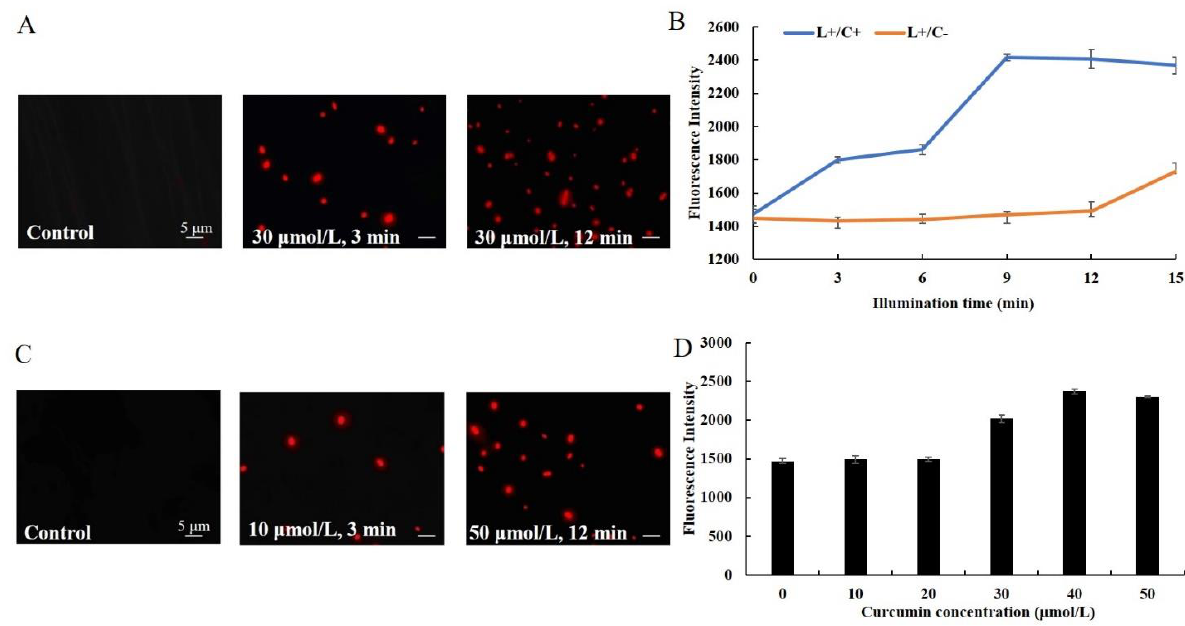
Figure 2. Changes of bacterial cell membrane permeability with different PDT treatments. The microscope images ( A ) and fluorescence intensity ( B ) of B. subtilis after Cur-PDT treatment with the illumination time of 3 and 12 min and 30 µ mol/L curcumin by PI staining. The microscope images ( C ) fluorescence intensity ( D ) of B. subtilis after Cur-PDT treatment with curcumin concentrations of 10 and 50 µ mol/L for 12 min by PI staining. The scale bar in the panel is five microns and all panels have the same